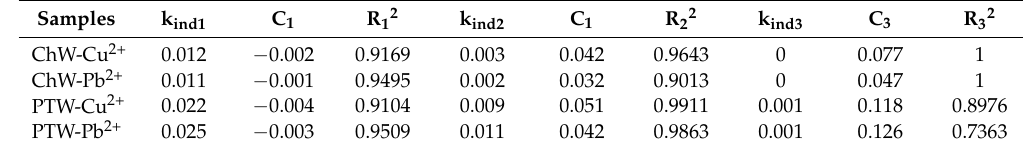
Table 6. The intra-particle diffusion for ChW and PTW on Pb 2+ and Cu 2+ .